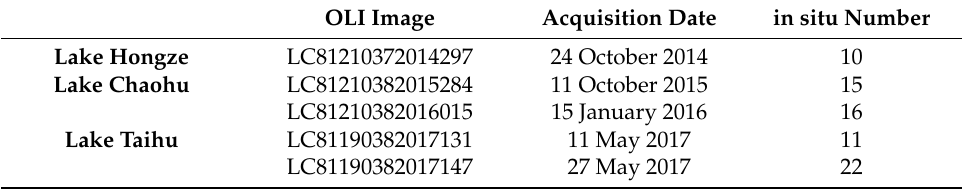
Table 2. The match-up dates of in situ measurement and OLI data acquisition over lakes Hongze, Chaohu, and